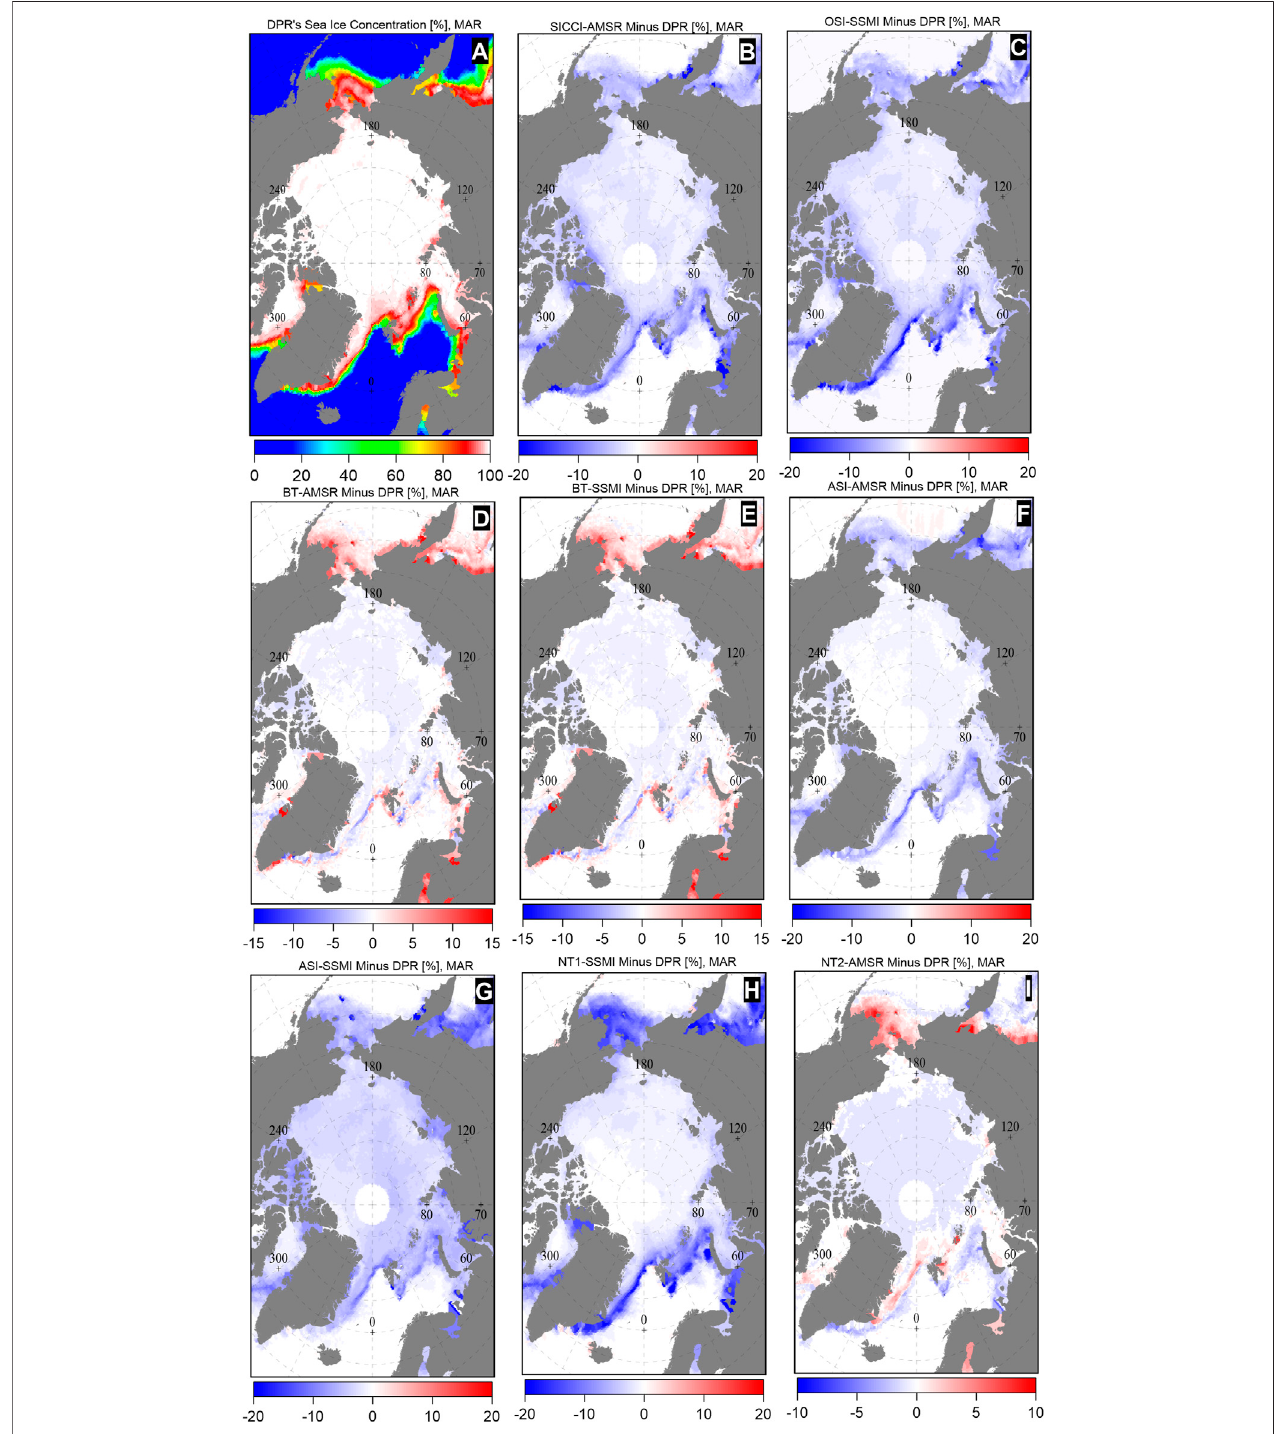
FIGURE7| Maps ofdifferences betweenthe multi-annual averagemonthlysea ice concentration ofDPR-AMSR and other eight sea iceconcentrationdata sets in March (2002 – 2015): SICCI-AMSR (B) , OSI-SSMI (C) , BT-AMSR (D) , BT-SSMI (E) , ASI-AMSR (F) , ASI-SSMI (G) , NT1-SSMI (H) , and NT2-AMSR (I) . (A) is the sea ice concentration map of DPR-AMSR. Differences were only computer for DPR-AMSR sea ice concentration > 15%.